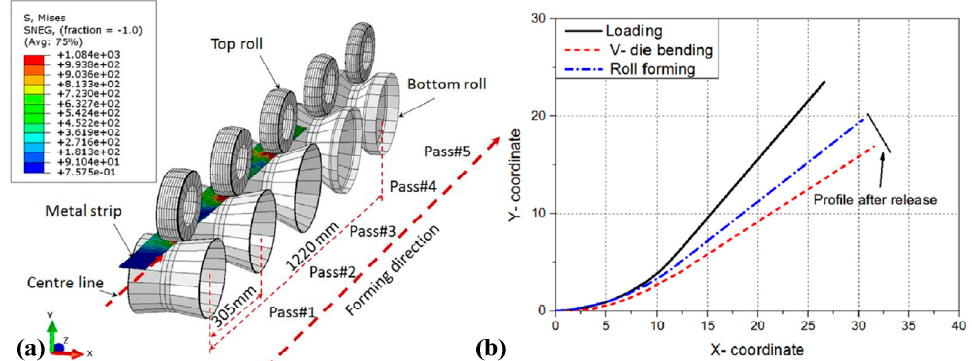
Figure 14. ( a ) Finite element models for V-roll-bending of Ti-6Al-4V sheets and ( b ) springback results obtained by HAH model [107]. Reprinted with permission from Ref. [107]. Copyright 2017, Int. J. Mech. Sci.